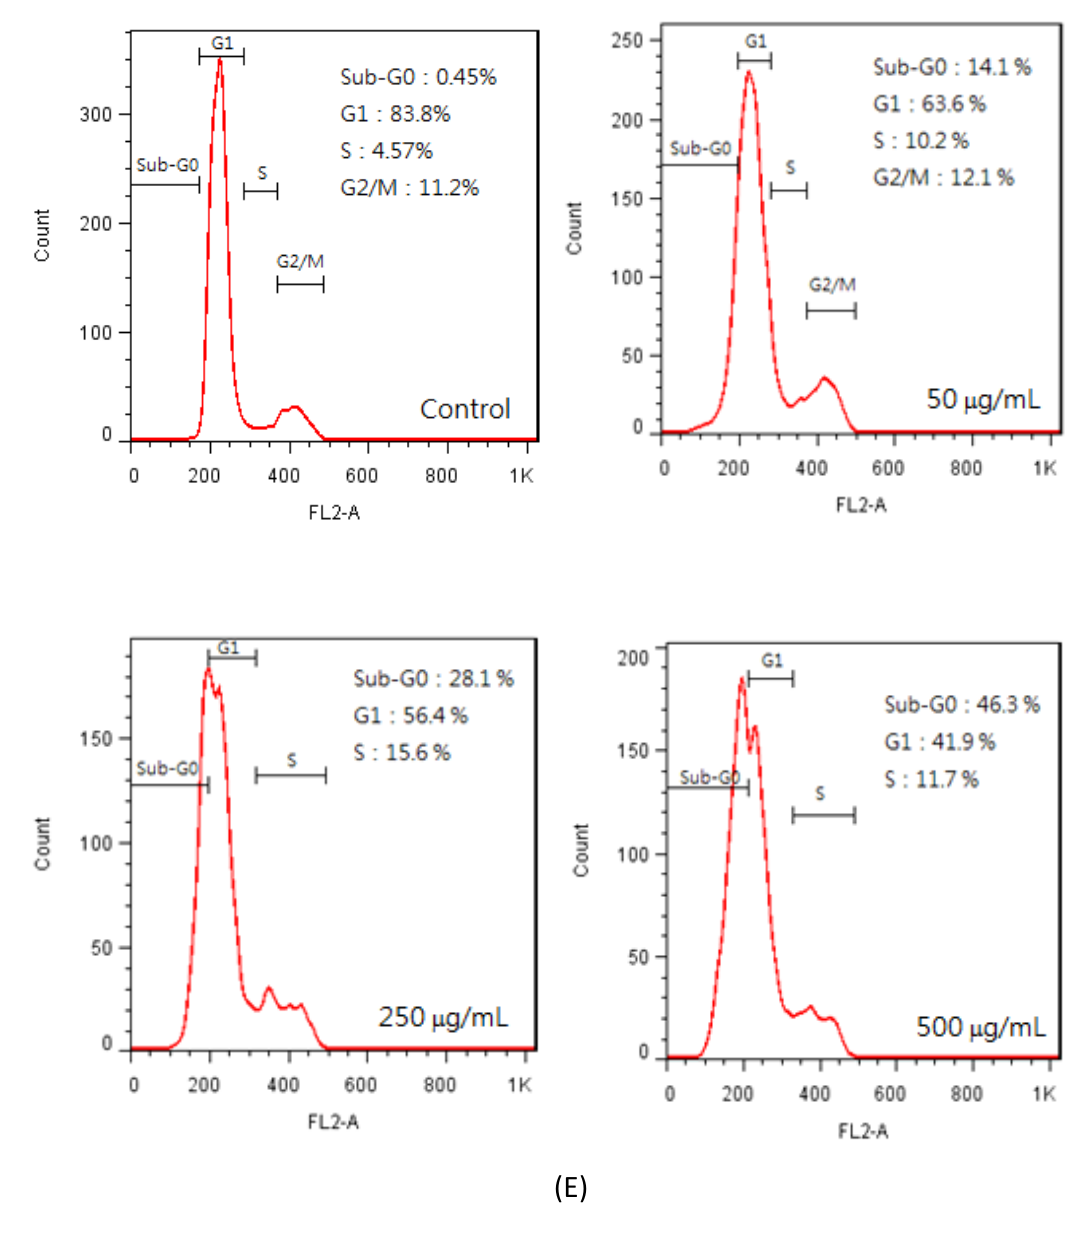
Figure 1. The cell viability and apoptotic e ff ect of ethanolic extracts of djulis husk (EEDH) on HepG2 cells. ( A ) E ff ect of EEDH on cell viability. After EEDH-treated cells for di ff erent incubation time, cell viability was determined by MTT assay. ( B ) E ff ect of EEDH treatment on cell disruption was determined by lactate dehydrogenase (LDH) leakage assay. The results are expressed as percent of LDH activity in the culture medium relative to the total enzyme activity. ( C ) E ff ect of EEDH on apoptosis in HepG2 cells. The cells were harvested and stained with Annexin V-FITC and propidium iodide (PI) and determined by flow cytometry. ( D ) Chromatin condensation was determined by 40,60-diamidino-2-phenylindole (DAPI) staining after EEDH treatment. The DAPI-stained cells were evaluated using fluorescence microscopy (200 × ). The arrow indicated apoptotic cells. ( E ) E ff ect of EEDH on the cell cycle of HepG2 cells. The cells were incubated with EEDH for 72 h ( A – E ). The data are expressed as the mean ± SD ( n = 3). * indicated significant di ff erence from the control ( p <